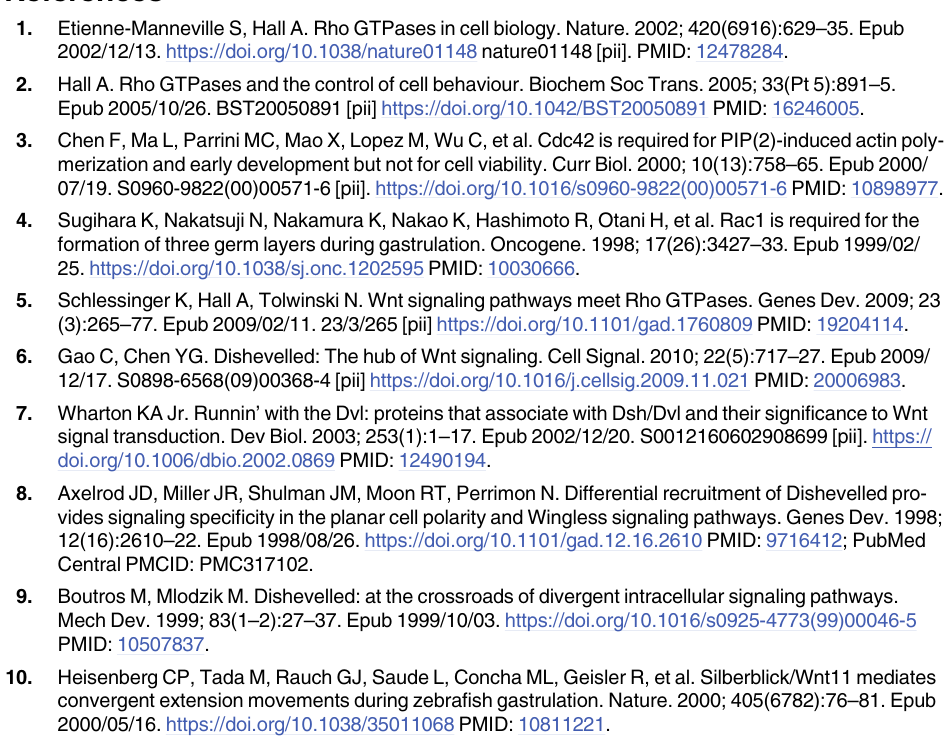
S1 Table. Transplantation of fetal liver cells into lethally irradiated recipient